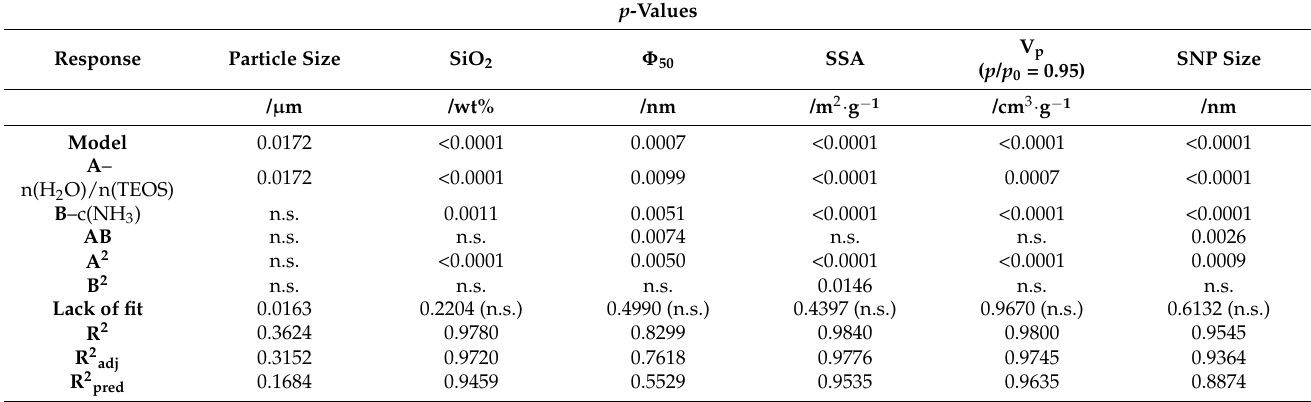
Table 2. Excerpt from the analysis of variance (ANOVA) tables with p -values for the response surface models of the target response variables particle size, SiO 2 content, median pore diameter ( Φ 50 ), specific surface area (SSA), pore volume (V p ) and size of the SNPs, as well as their fit statistics. Complete ANOVA tables for each model are given in Appendix C Tables